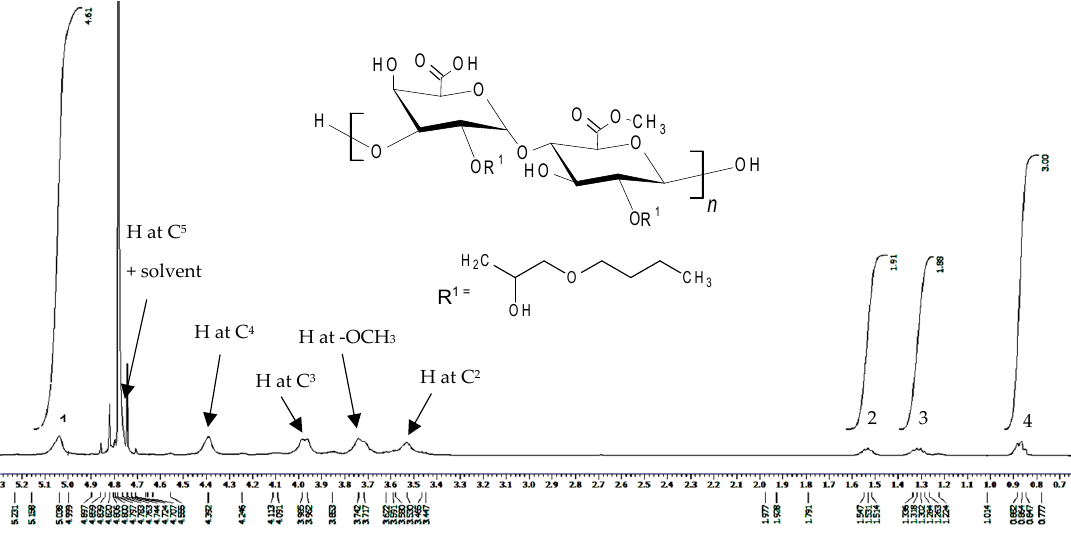
Figure 3. Proton nuclear magnetic resonance ( 1 H-NMR) spectrum of P-OX4 in D 2 O (5 mg/mL).